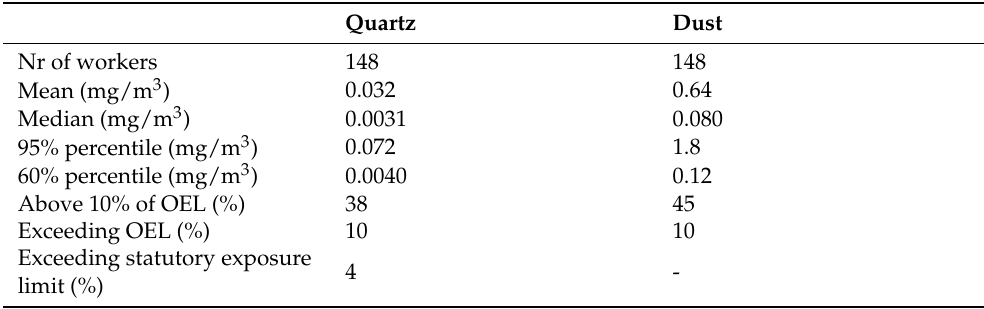
Table 2. Estimated respirable quartz and dust exposures in work tasks, taking into account respiratory protection when it was used.